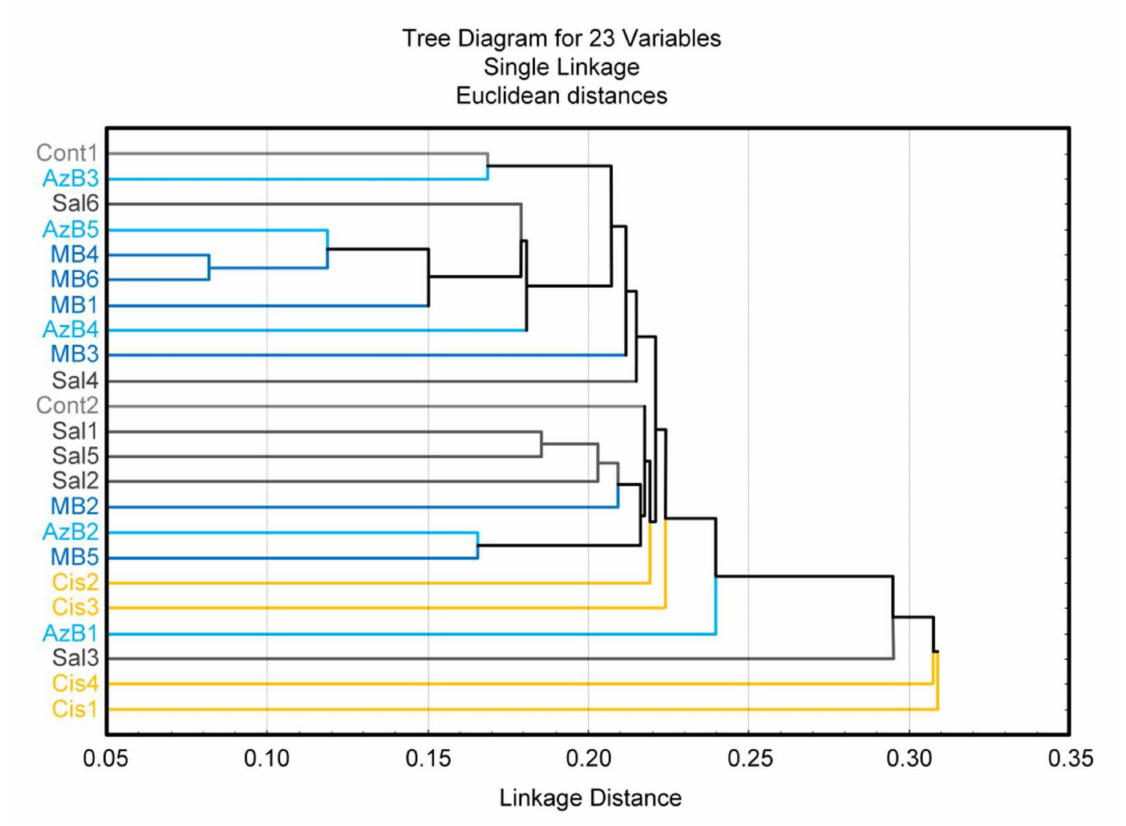
Figure 8. Cluster